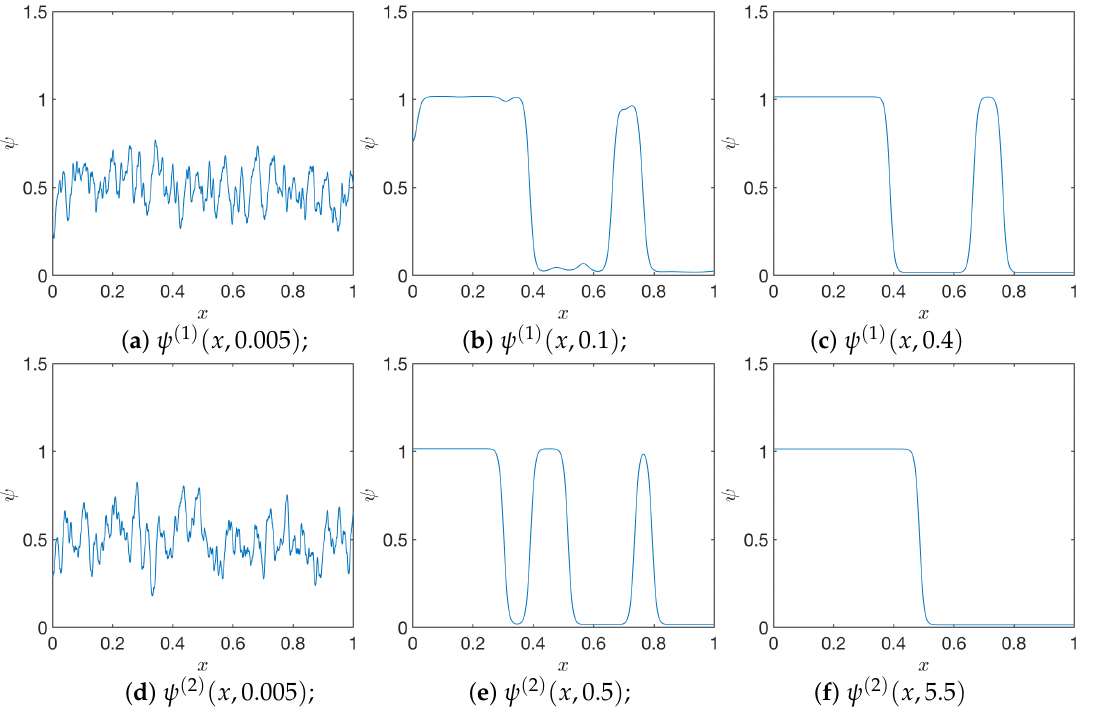
( i ) ( x ) with i = 1 (top) and i = 2 (bottom) at three different init